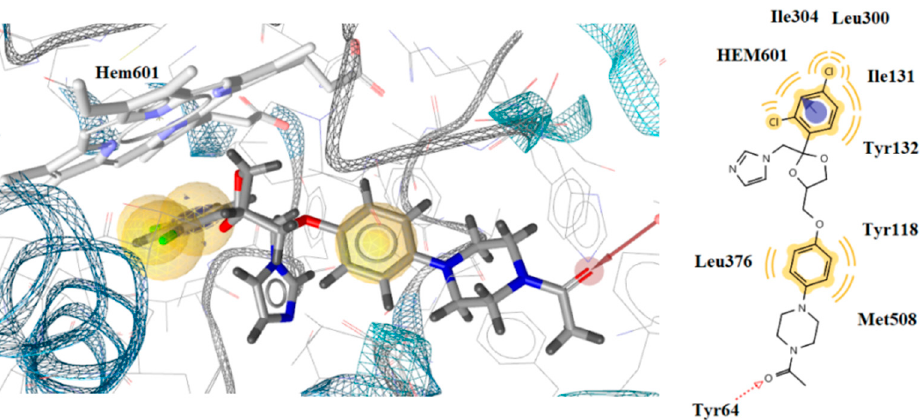
Figure 3. Docked conformation of ketoconazole in lanosterol 14 α -demethylase of C . albicans (CYP51 ca ).